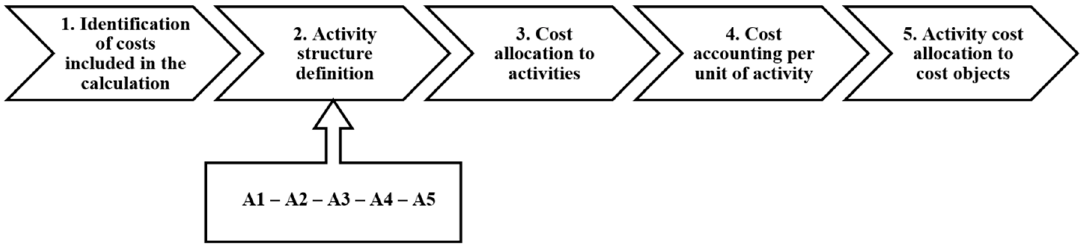
Figure 1. Component phases of the Activity Based Costing (ABC) method.